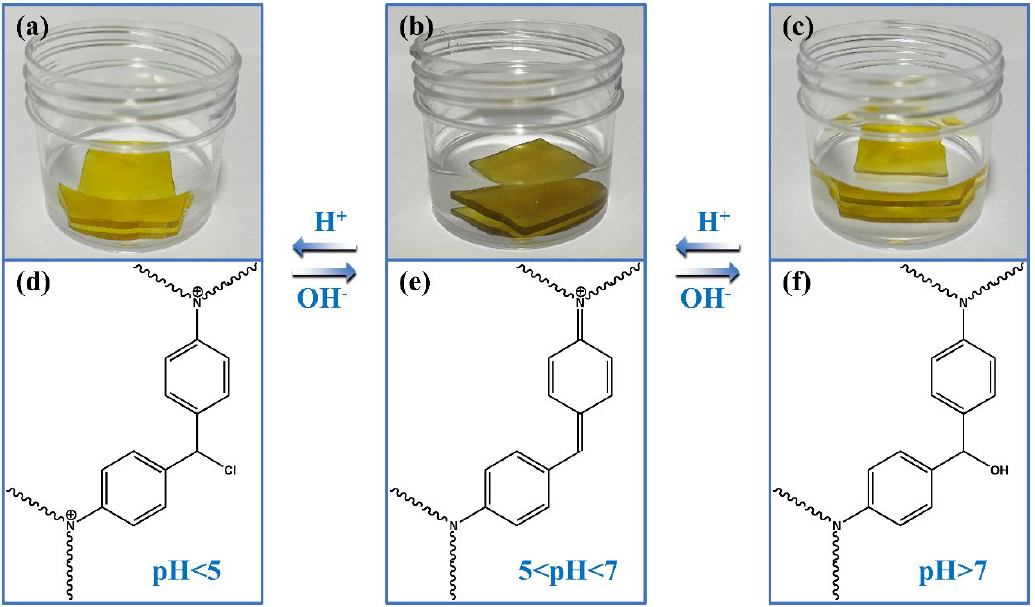
Figure 9. The pH − response of FUW: the photos of FUW in strong acid solution ( a ), weak acid solution or neutral solution ( b ), and alkali solution ( c ); the structures of FUW in strong acid solution ( d ), weak acid solution or neutral solution ( e ), and alkali solution ( f ).